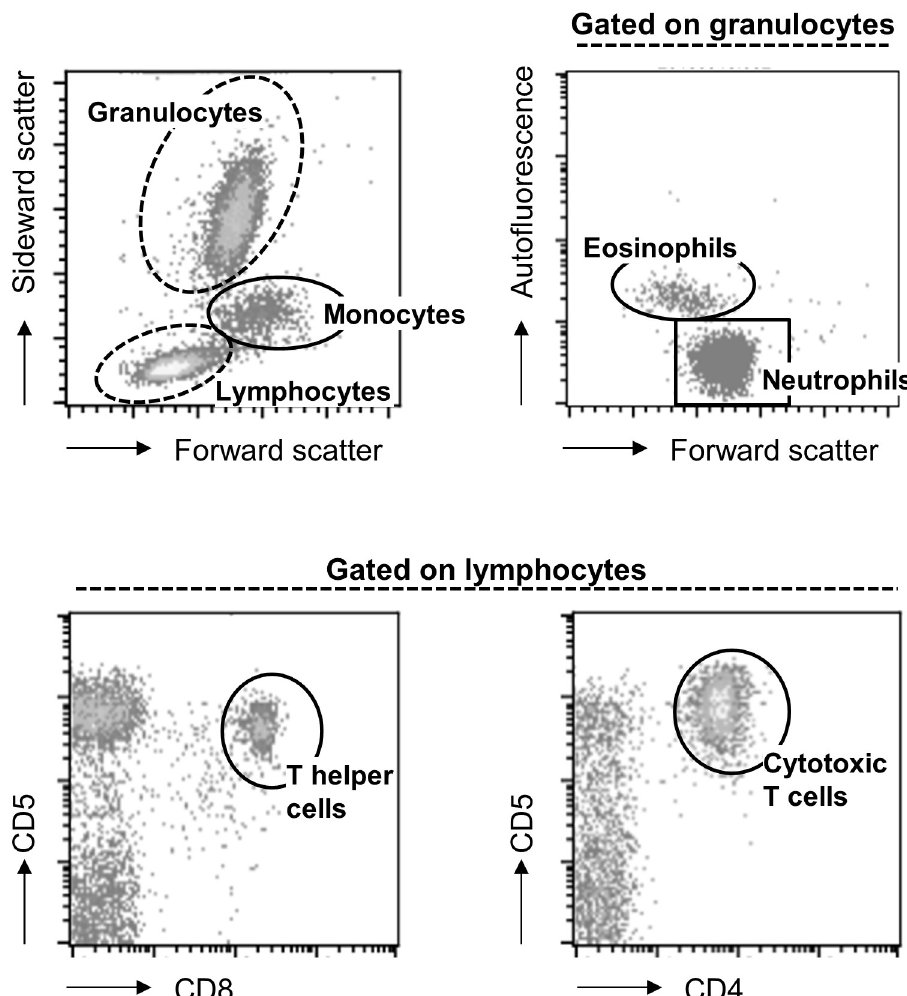
Fig 2. Gating strategy for flow cytometric discrimination of equine leukocyte populations in whole blood. Immune cells were left unlabeled or labeled with an antibody specific for equine CD5 in combination with an antibody either specific for equine CD8 or for equine CD4 and analyzed on a flow cytometer.